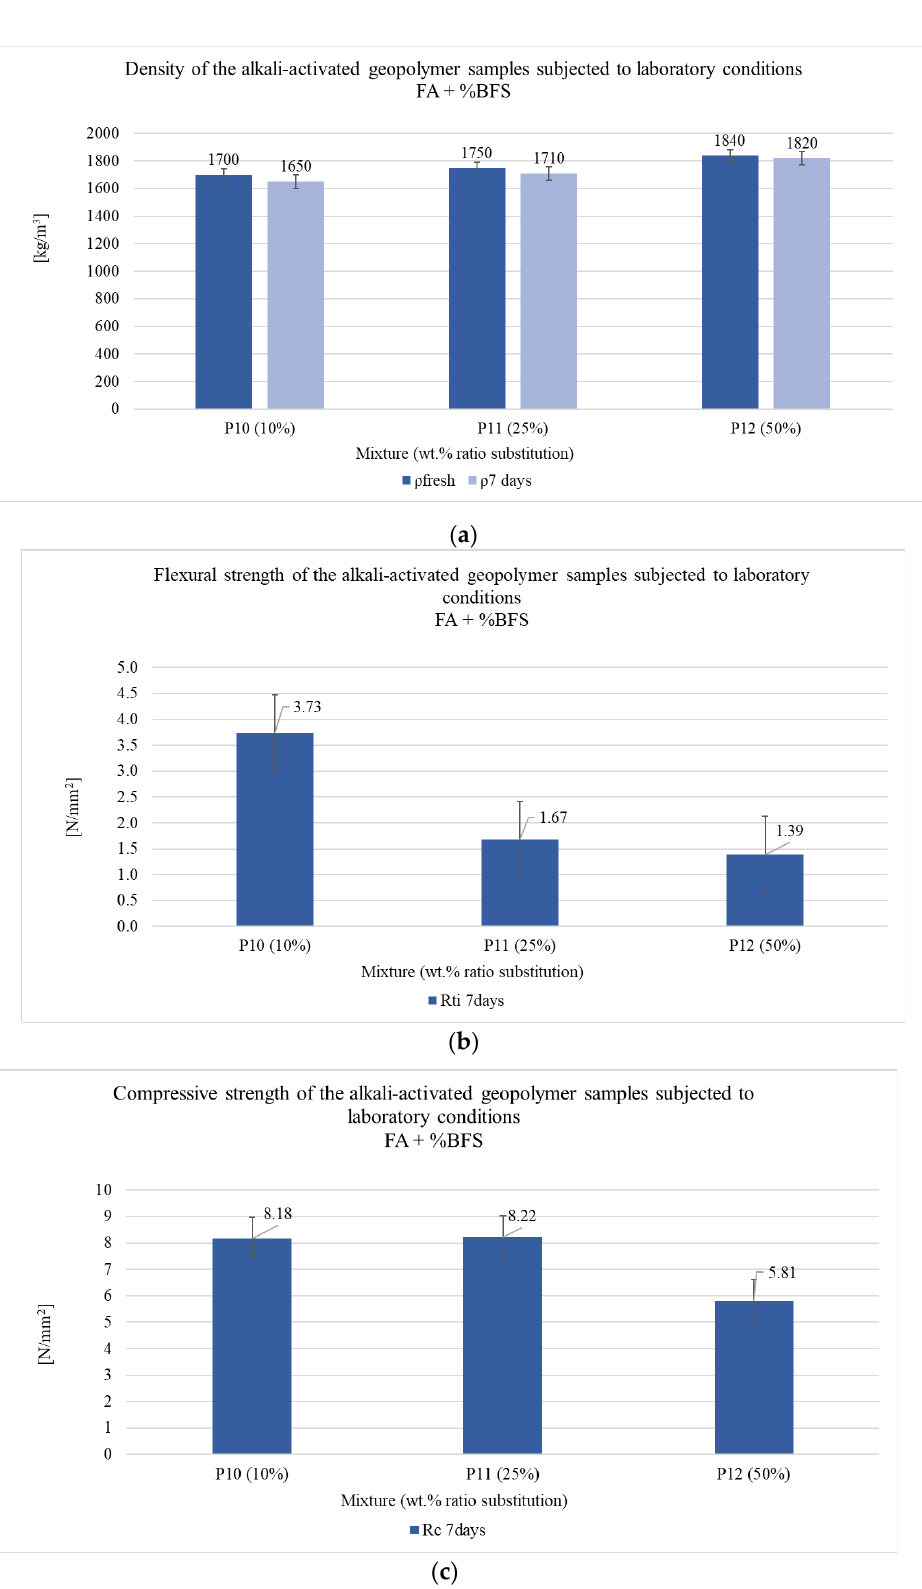
Figure 4. Physico-mechanical performances of the alkali-activated geopolymer binder using BFS as FA substitution subjected laboratory conditions: ( a ) Apparent density; ( b ) Flexural strength and ( c ) Compressive strength.